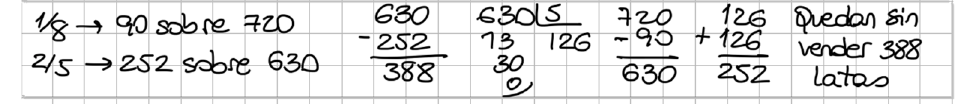
Figure 2. PT21’s written answer to problem FWP2. (Translation of PT21’s solution: “504 cans will remain unsold.”).